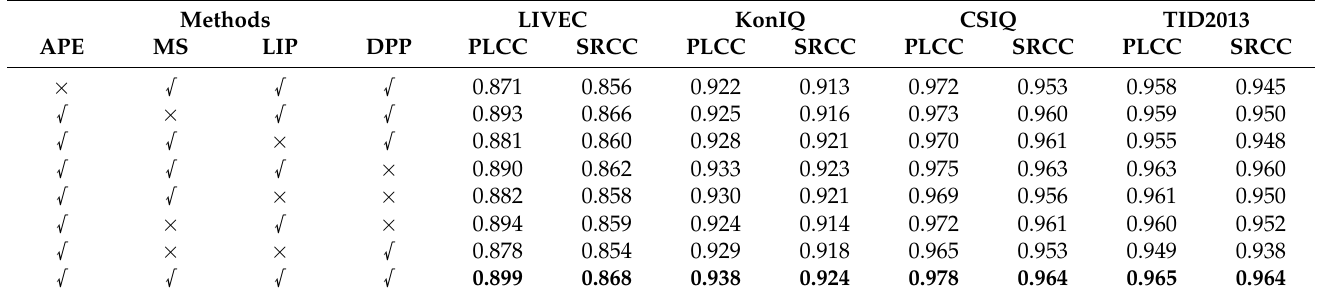
Table 6. PLCC and SRCC results of ablation experiments on the LIVEC, KonIQ, CSIQ, and TID2013